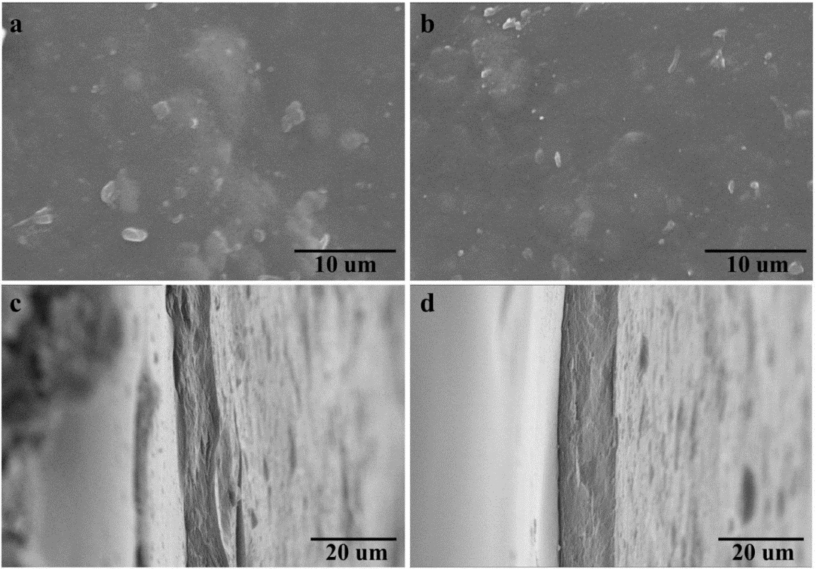
Figure 6. ( a – d ) SEM images of the regenerated H-film and A-film. ( a , b ) the surface of H-film and A-film; ( c , d ) the cross section of H-film and